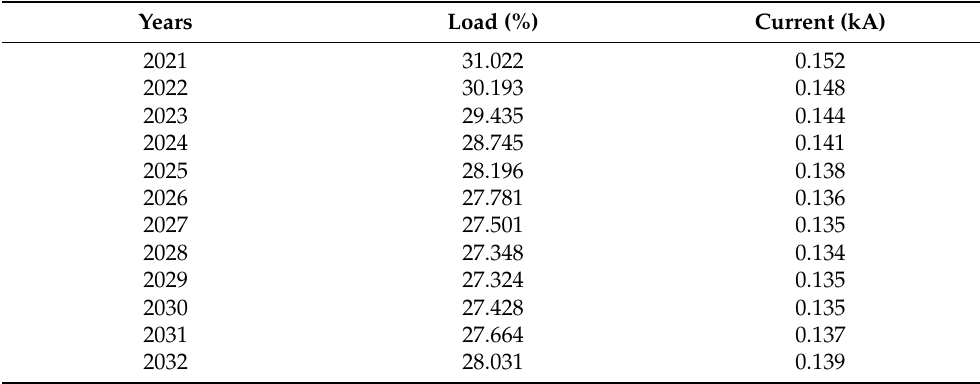
Table 6. Transmission line evolution with a higher average